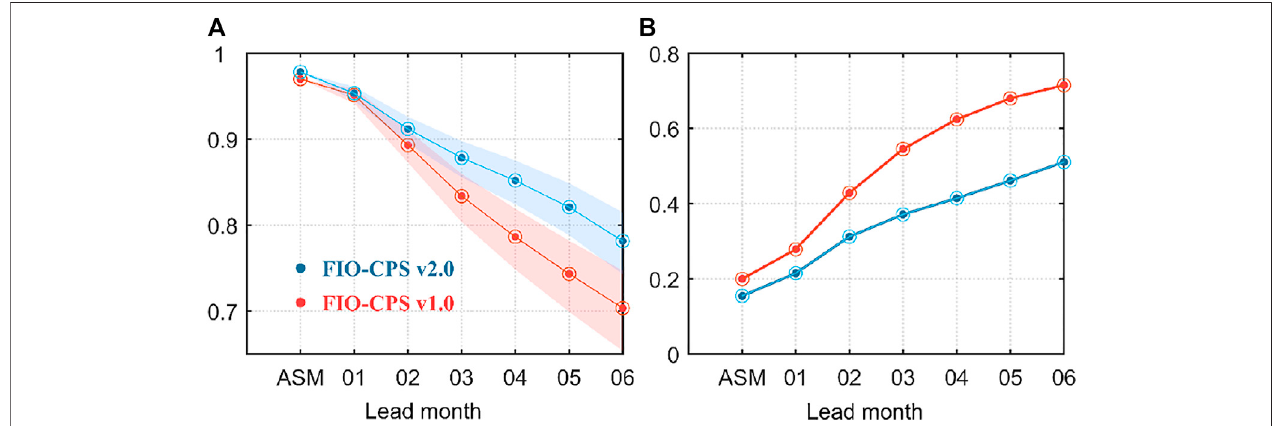
FIGURE 4 | (A) ACC and (B) RMSE of the Niño 3.4 index between the OISST v2.1 and the simulation for 1993 – 2019. The red and blue lines represent the assimilated and predicted results of FIO-CPS v1.0 and FIO-CPS v2.0 for 1-month to 6-month lead times, and the shaded area in (A) indicates the 95% con fi dence